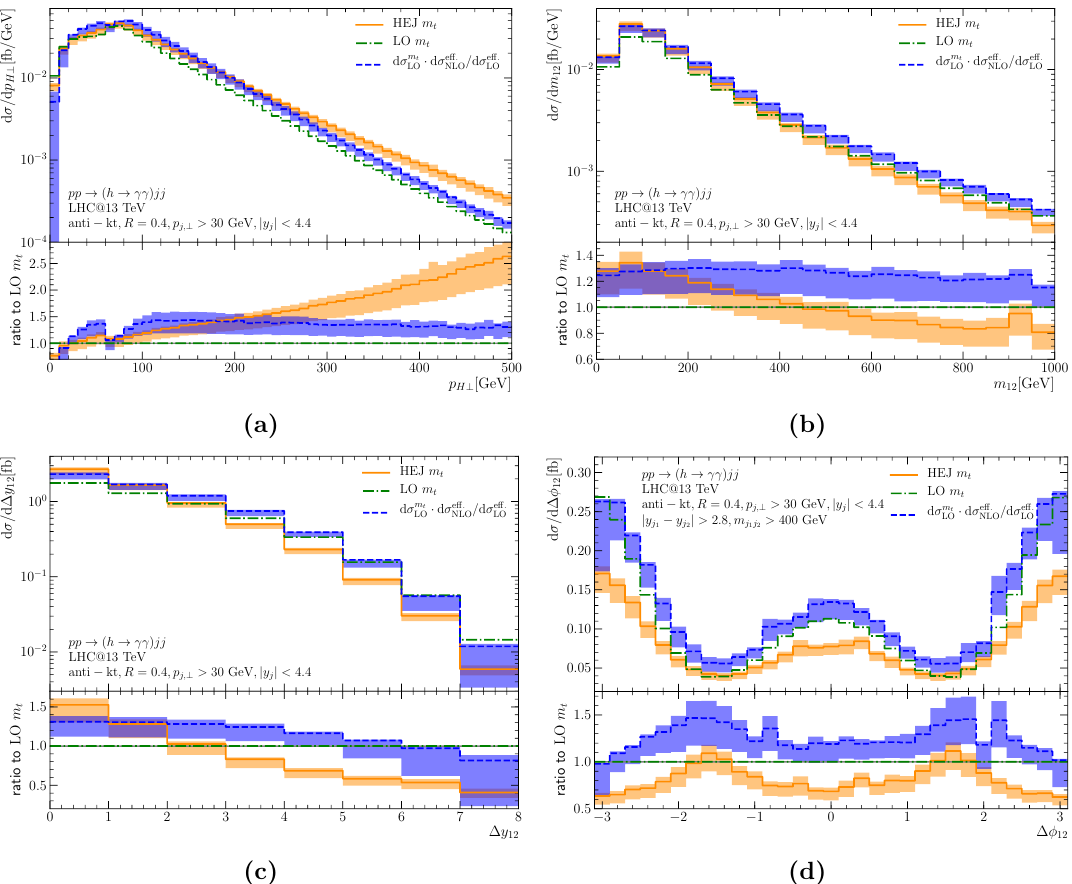
Figure 13 . Predictions for various distributions obtained with HEJ, pure leading order, and leading order rescaled with di(cid:11)erential K factors for the central scale choice (cid:22) r = (cid:22) f = H T = 2. See (cid:12)gure 9 for the corresponding plots with (cid:22) r = (cid:22) f = max( m H ; m 12 ).